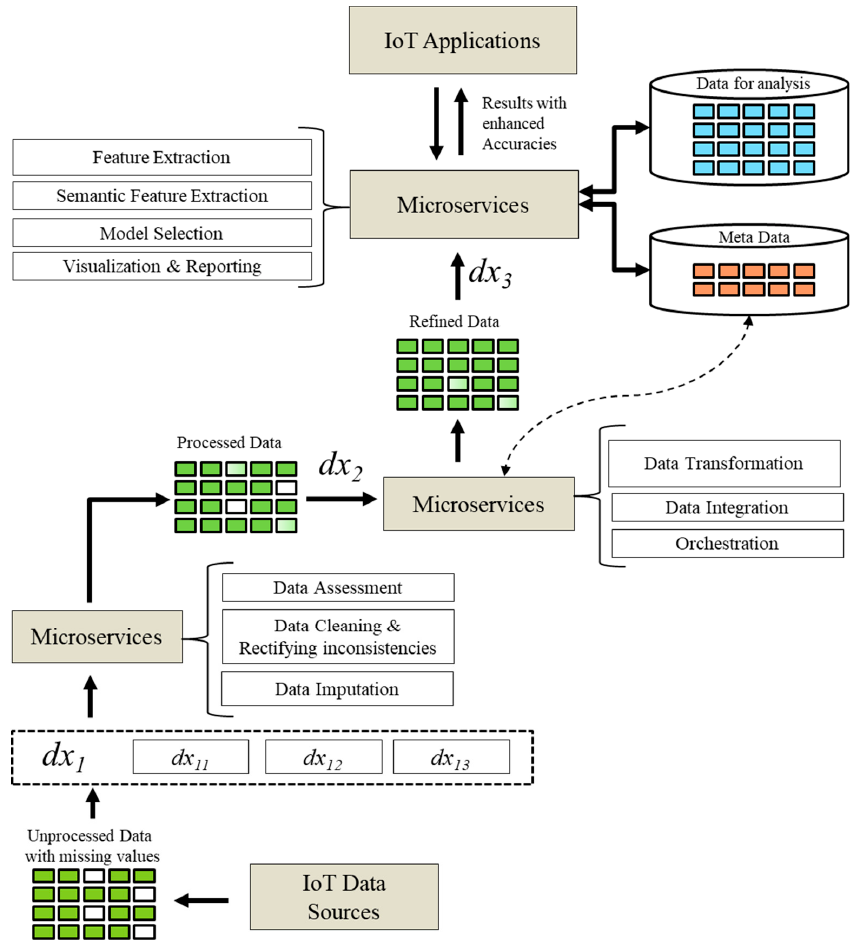
Figure 2. Procedures to achieve predictive analytics.